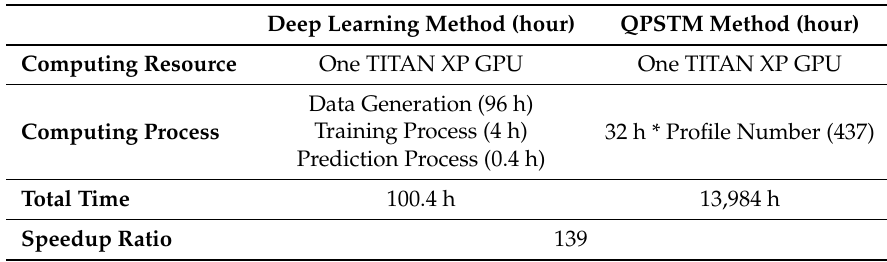
Table 2. Comparison of the deep learning method and QPSTM